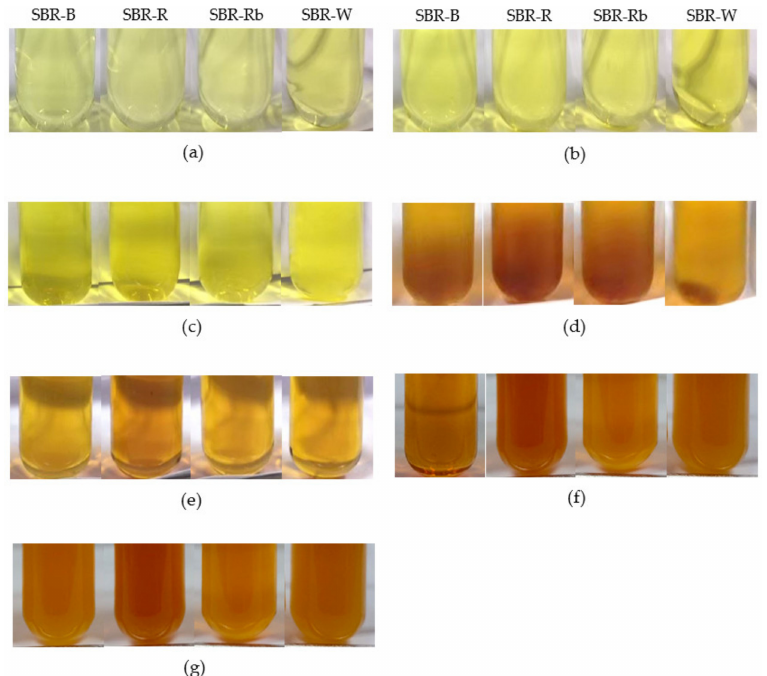
Figure 3. Color of crude extract solutions (20 mg/mL) prepared from different solid-based residues (SBRs) with different solvents: ( a ) ethyl acetate; ( b ) acetone; ( c ) ethanol; ( d ) 50% ( v / v ) acetone; ( e ) 50% ( v / v ) ethanol; ( f ) water; and ( g ) hot